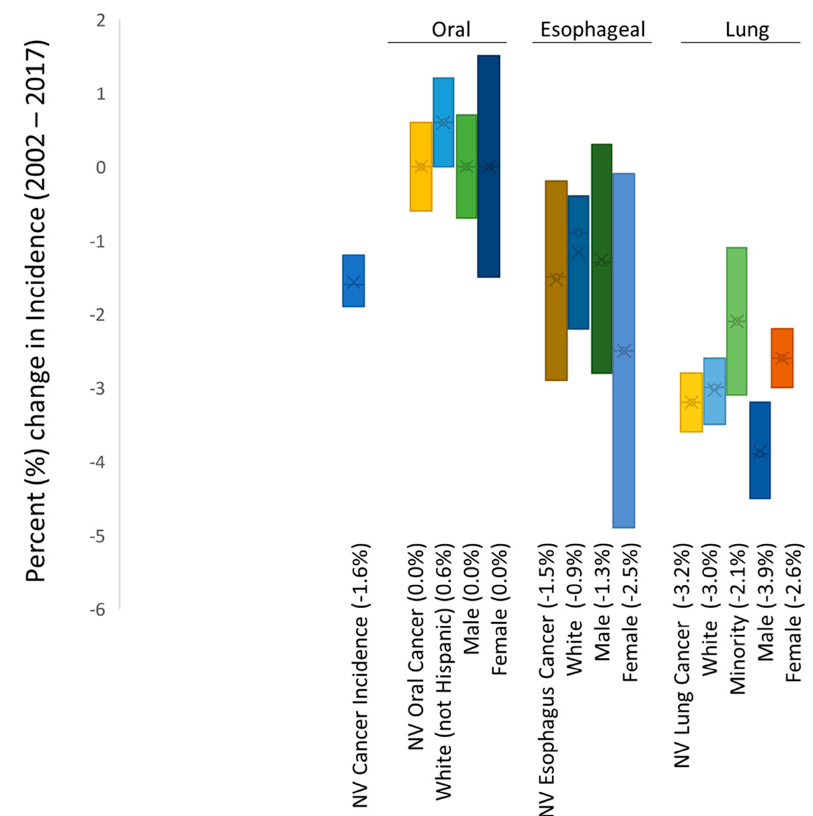
Figure 1. Analysis of smoking-related cancer incidence rates in Nevada 2002–2017. Differential results demonstrated stable rates of oral cancer incidence (0.0%) with declining rates of esophageal cancer incidence ( − 1.5%) associated mainly with females ( − 2.5%), as well as declining rates of lung cancer incidence ( − 3.2%), which were most strongly associated with declining rates among males ( − 3.9%). Note: insufficient data were available to analyze or plot non-White oral and esophageal cancer incidence in